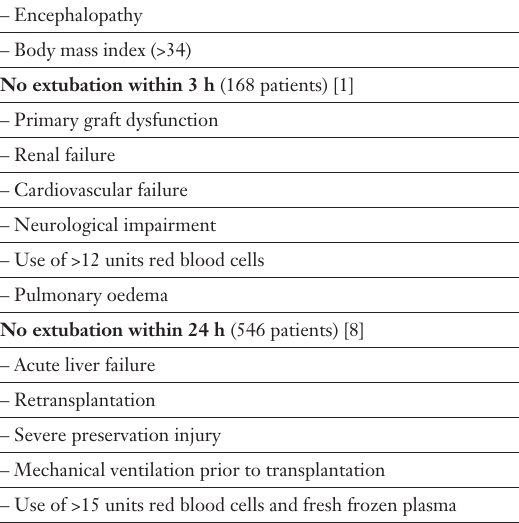
Risk factors for prolonged mechani- cal ventilation after OLT; results from multivariate logistic regression